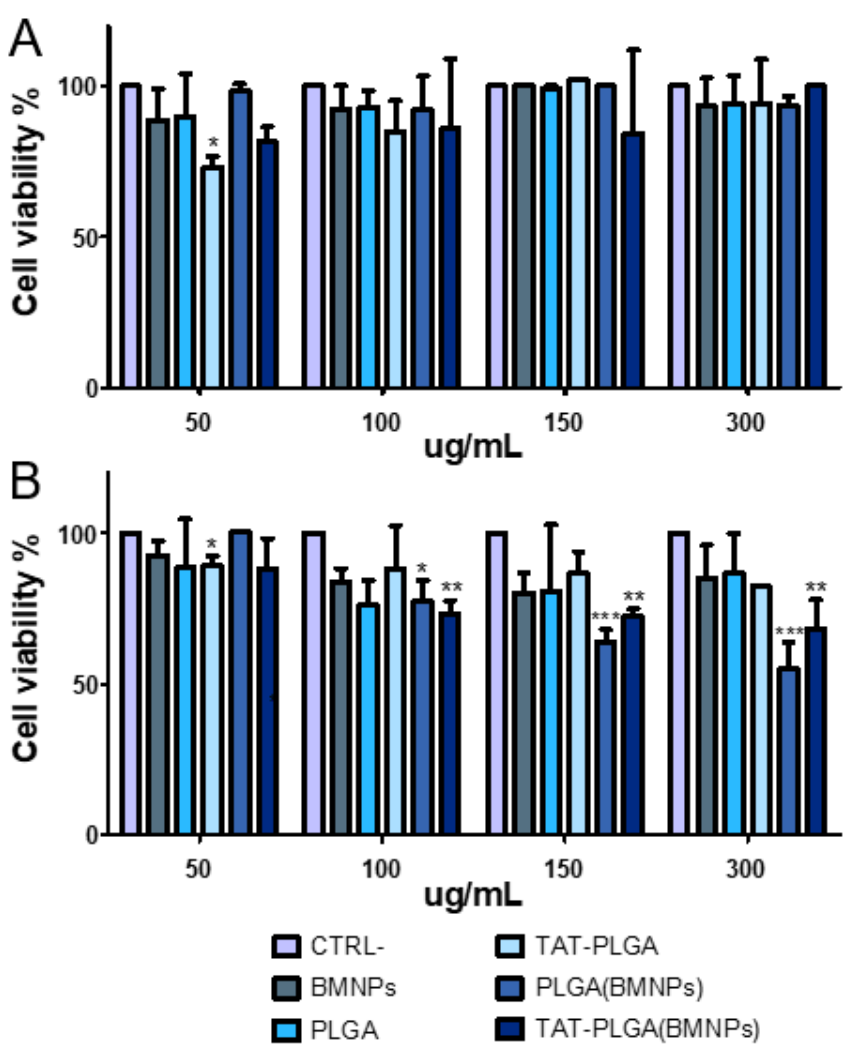
Figure 5. Cell proliferation assay of U87MG. U87MG cells were treated with the different samples after 48 ( A ) and 72 ( B ) hours. Statistical differences between the treatments were considered significant when p values were p ≤ 0.05 (*), p ≤ 0.01 (**), p ≤ 0.001 (***).